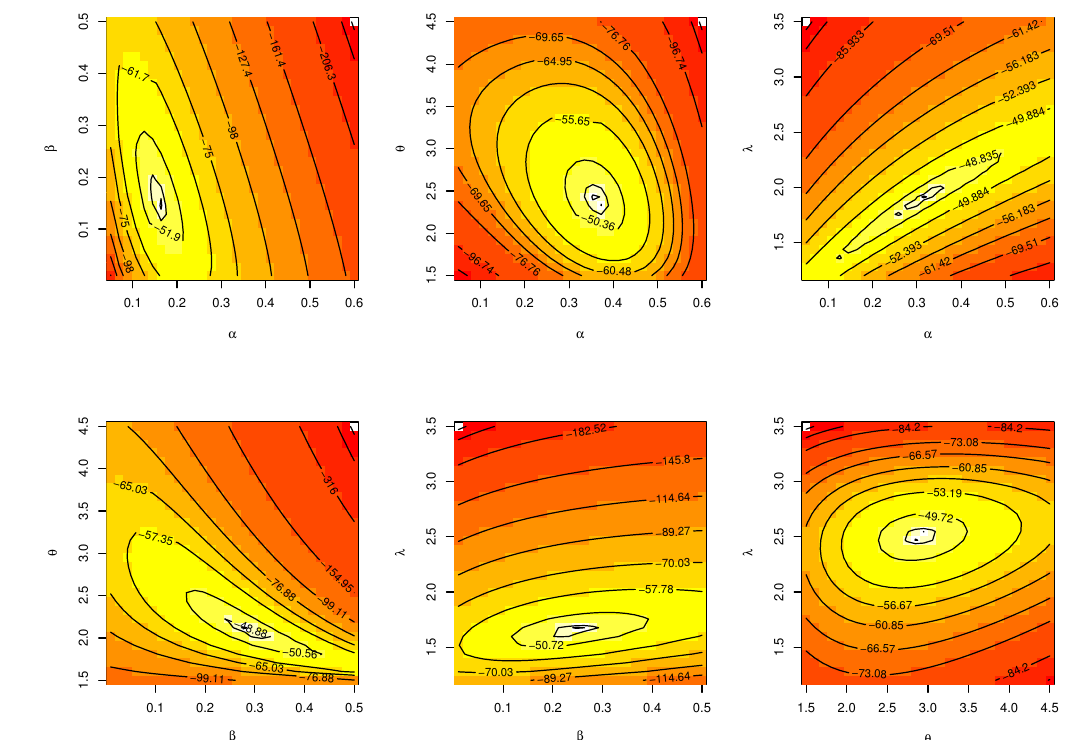
Figure 26. Contour plot for parameters of TLMW model for single carbon fibers.